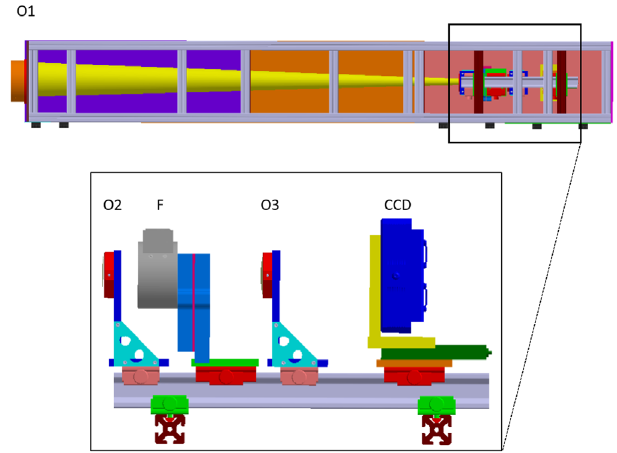
Fig. 2. Mechanical con fi guration of the L1 refractor with a zoom on its back